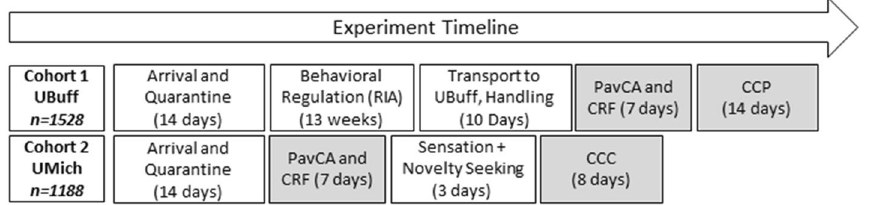
Table 1. Timeline for the University at Buffalo and Michigan cohorts. Rats arrived at both testing sites, and were quarantined for 14 days before entering the study. Note that the UBuff cohort was tested at the Research Institute on Addictions on several non-drug behavioral regulation tasks before being transported to the University at Buffalo. Rats were handled for a minimum of 7 days upon arrival. Blocks shaded in gray reflect the data presented in this